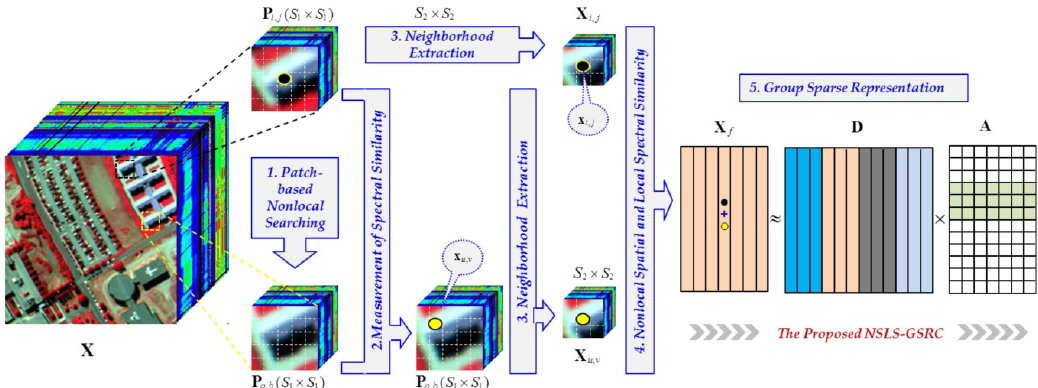
Figure 1. General framework. ( X : a HSI; P : a patch extracted from X ; S : the window size of the extraction; X i , j , X u , v : the neighborhoods centered on pixel x i , j and x u , v ; X f : the fusion matrix of X i , j and X u , v ; D : the dictionary of representation; A : the coefficient